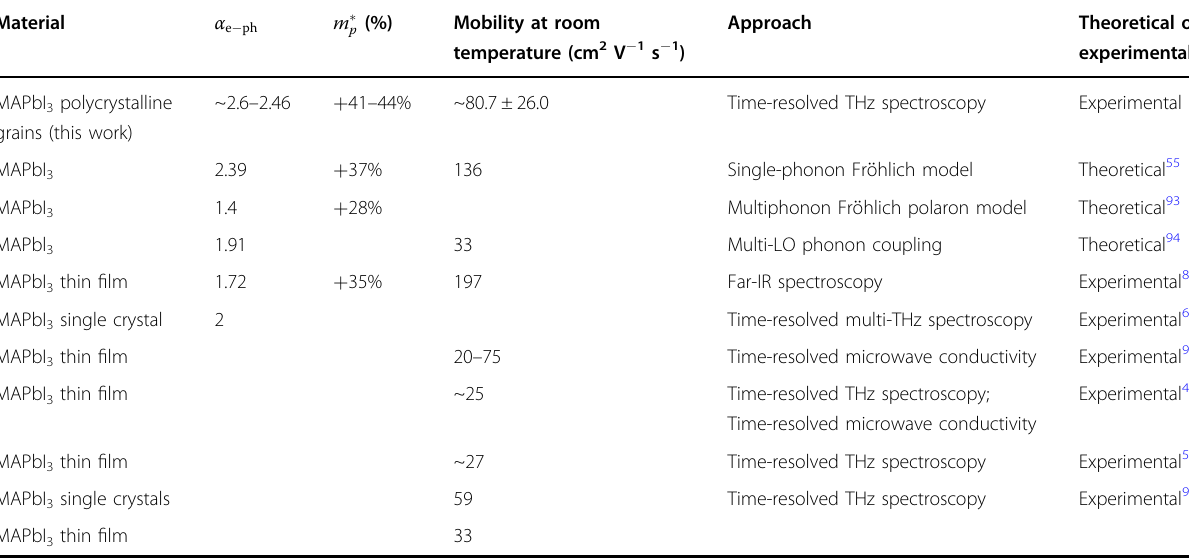
Table 1 Comparison of the Fro ̈ hlich coupling constant α e (cid:3) ph , polaron effective mass m (cid:6) mass m (cid:6) ) and mobility measured in MAPbI 3 with that from calculations and measurements in the literatures b